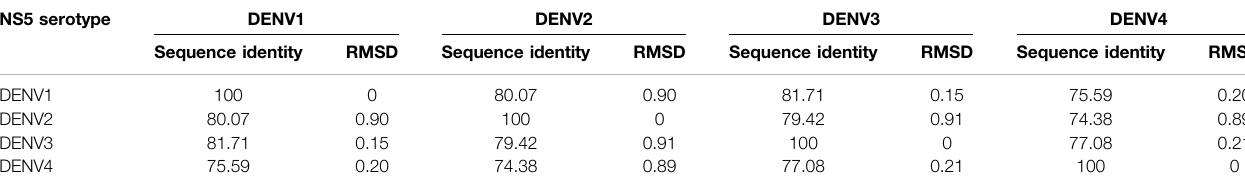
TABLE 1 | Percentages of sequence identity and structural RMSD (Å) between the NS5 protein of the four DENV serotypes. NS5 serotype